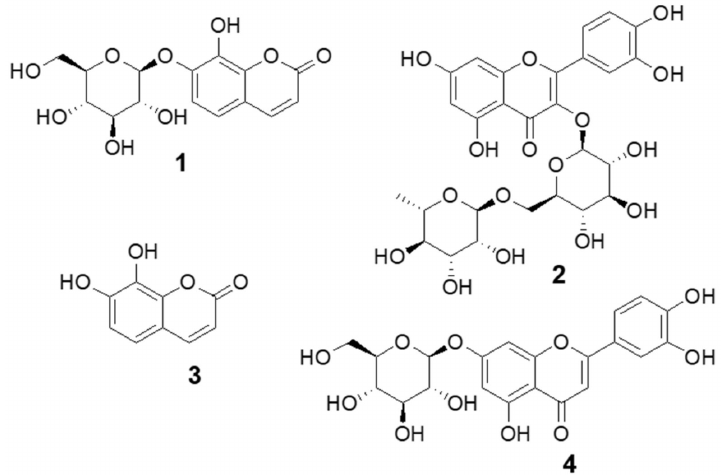
Figure 9. Structure of compounds identified from Daphne jejudoensis leaf extract (DJLE): daphnin ( 1 ), rutin ( 2 ), daphnetin ( 3 ), and cynaroside ( 4